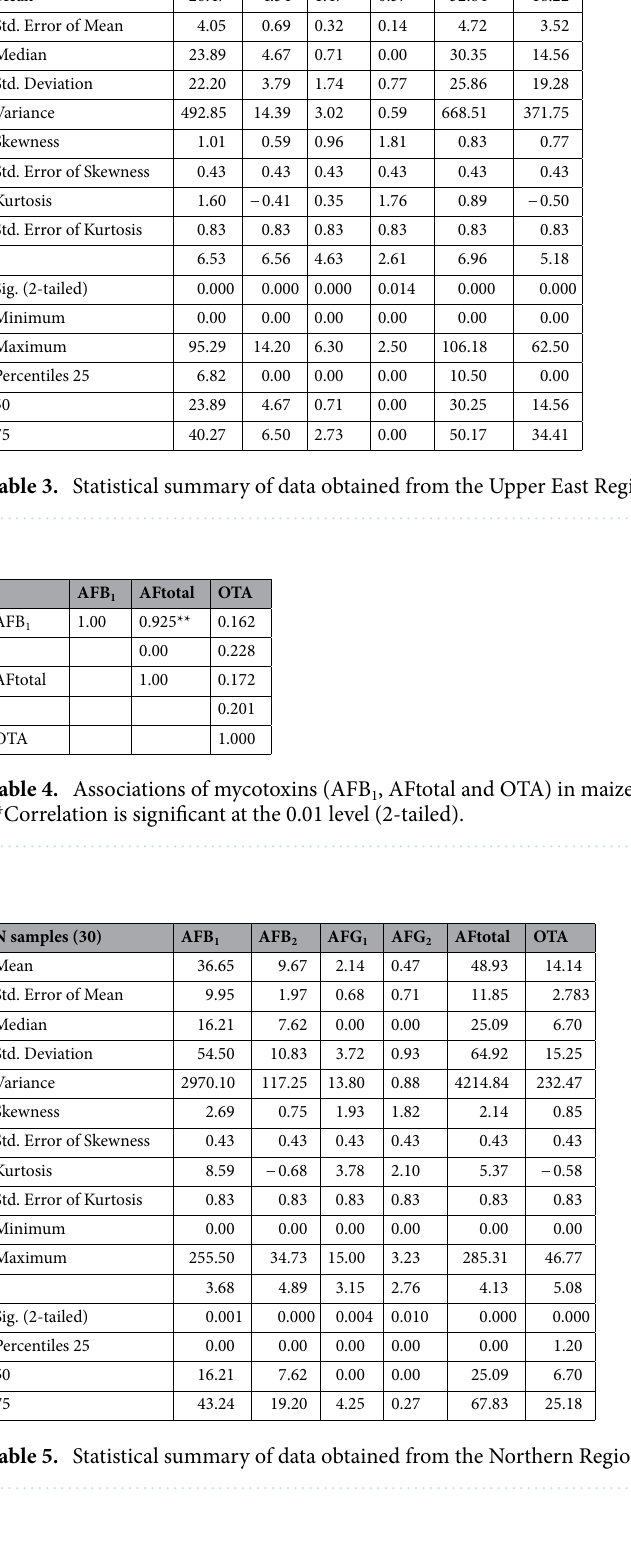
Table 5. Statistical summary of data obtained from the Northern Region of Ghana.